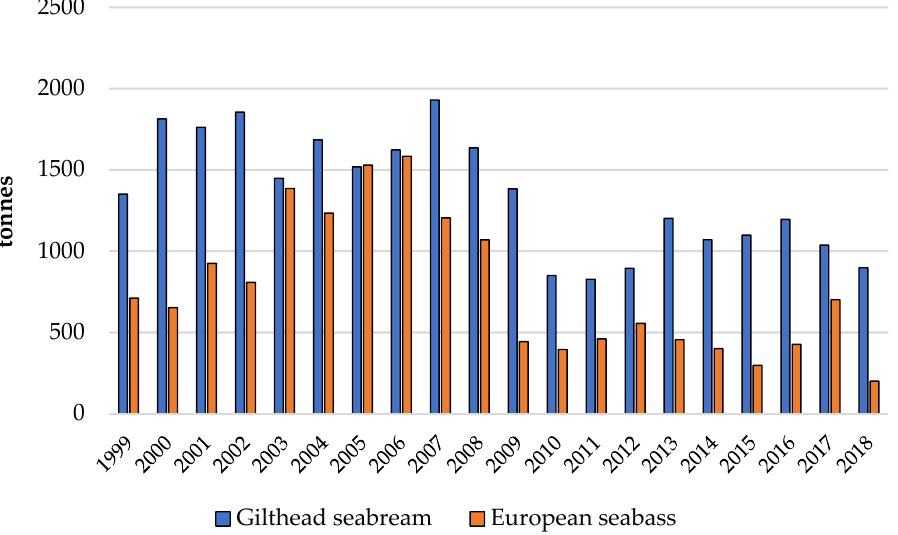
Figure 5. Total aquaculture production of the two main marine fish species cultured in brackish and marine waters in Portugal during the period from 1999 to 2018. Data sources: INE 2000; INE 2002- 2019.